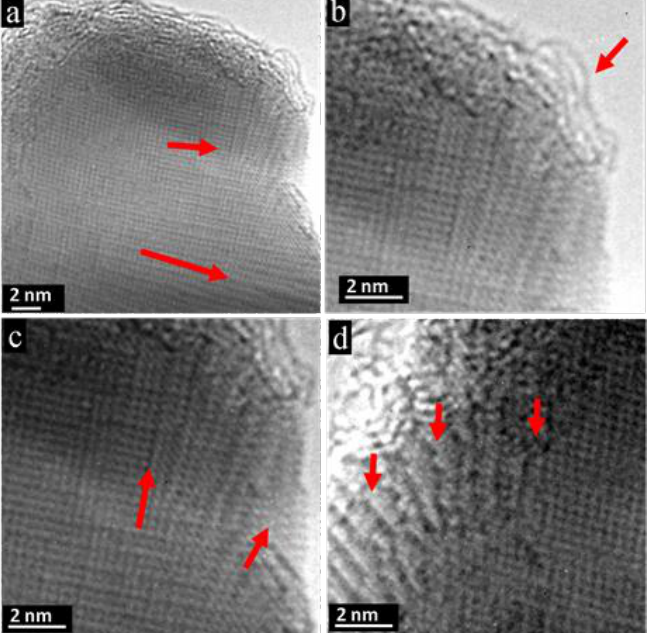
Figure 5. Depletion mechanism of PbTe. ( a ) Stress formation on PbTe crystal during depletion causes divergence of about 5 degrees between convexity and matrix concerning the (100) direction, see red arrows. ( b ) At the top of the convexity, atomic rows seem to be split from the uppermost surface, giving rise to fibrillation and coiling. ( c ) In addition, the (010) direction shows a divergence of about 10 degrees caused by internal tension. ( d ) Degradation of crystal lattice occurs layer-wise and atom-by-atom, as visualized at the edge of the convexity. Several typical kinks and steps are marked by red arrows.